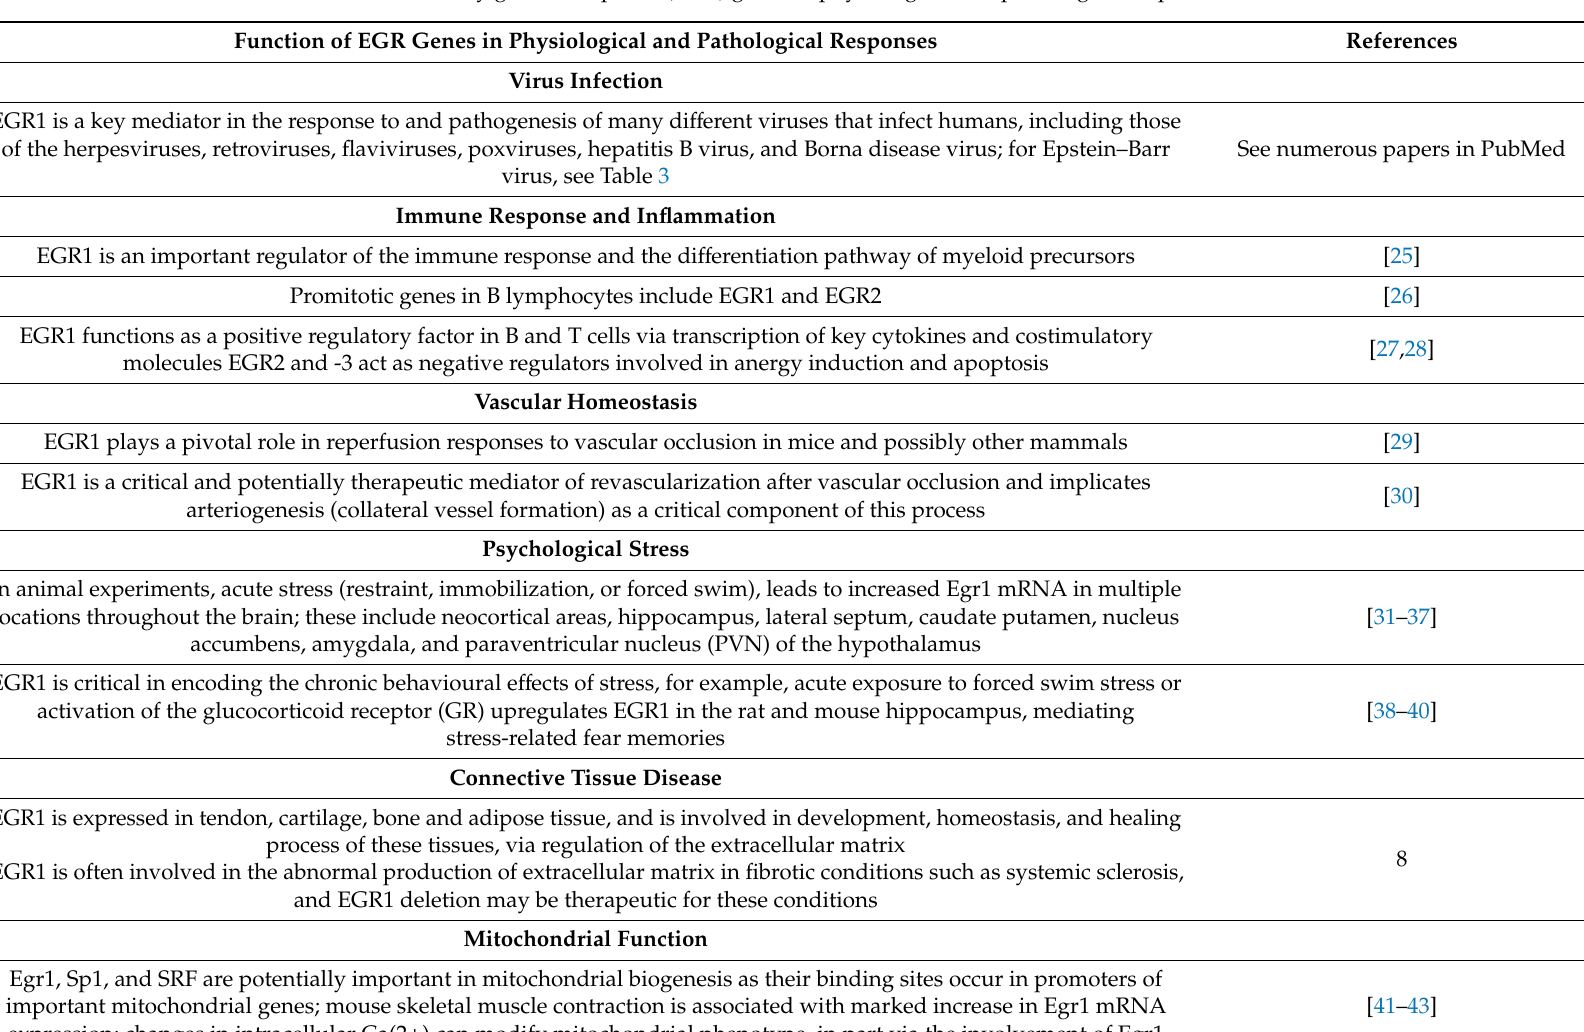
Table 2. Early growth response (EGR) genes in physiological and pathological